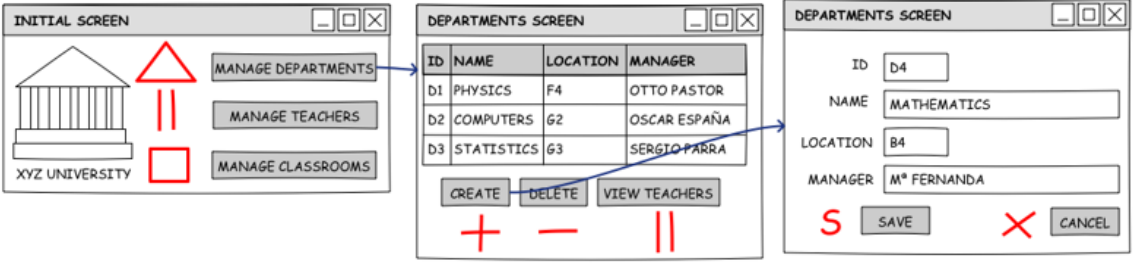
Figure 18. Screen mockups (gestures are shown in red, next to action